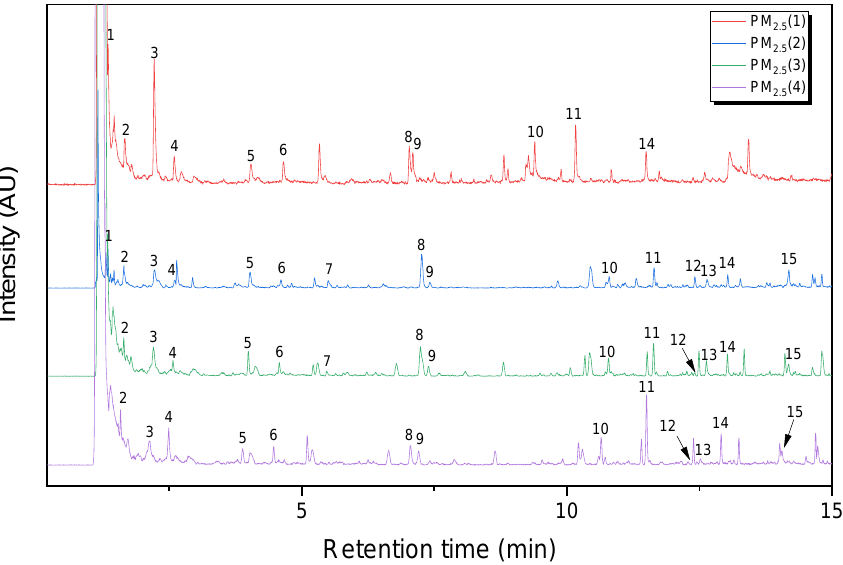
Figure 1. Py-GC/MS chromatogram of the PM 10 sample.